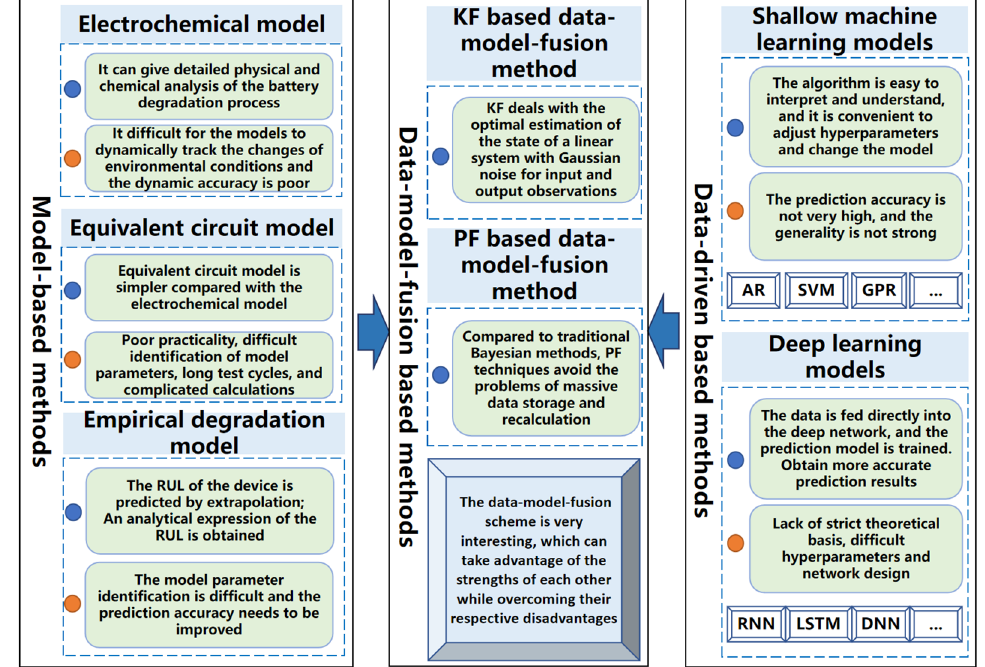
Figure 8. Research summary of the three categories of RUL prediction methods.